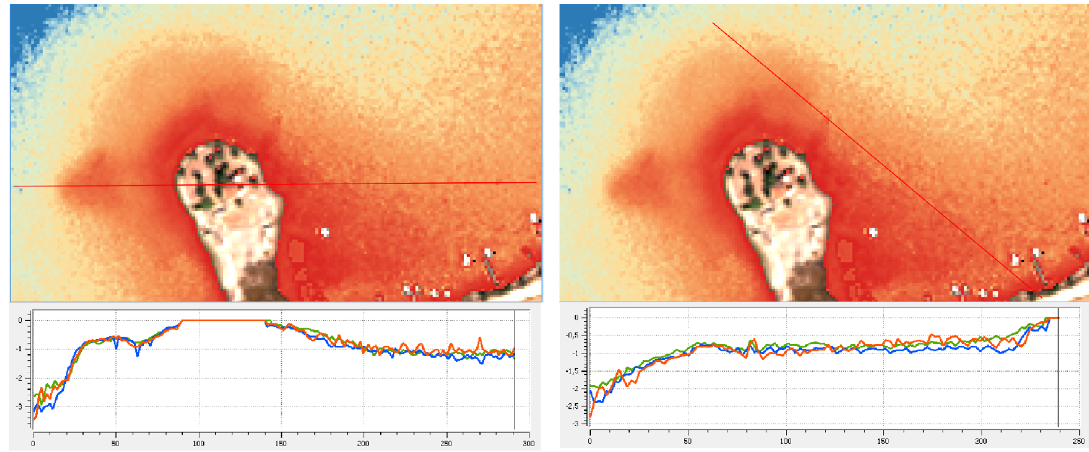
Figure 6: Example of two depth profiles extracted from the three bathymetric maps produced at Metohi: 26.10.2010 (green), 31.01.2013 (blue) and 19.09.2013 (orange).